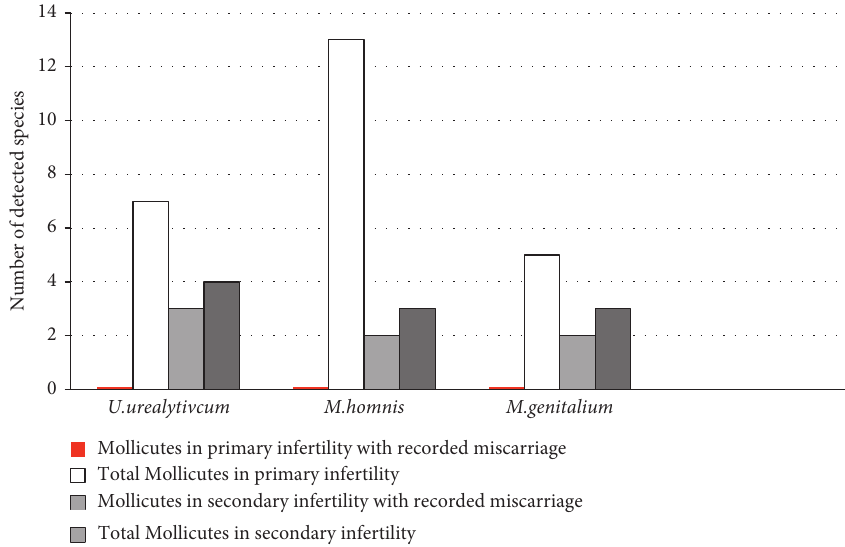
Figure 1: Mollicutes distribution among primary and secondary infertile patients. Table 4: Frequencies of Mollicutes infection in relation to different